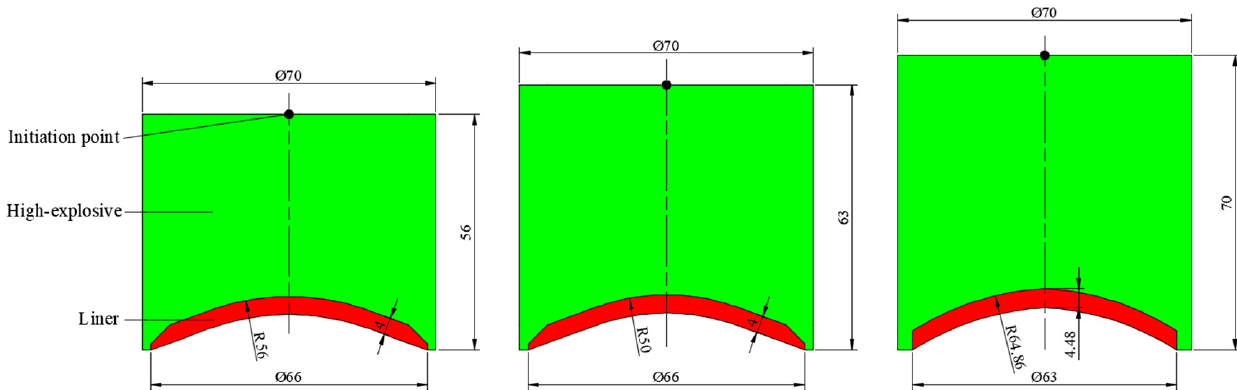
Figure 1. Three EFP-shaped charge structures.